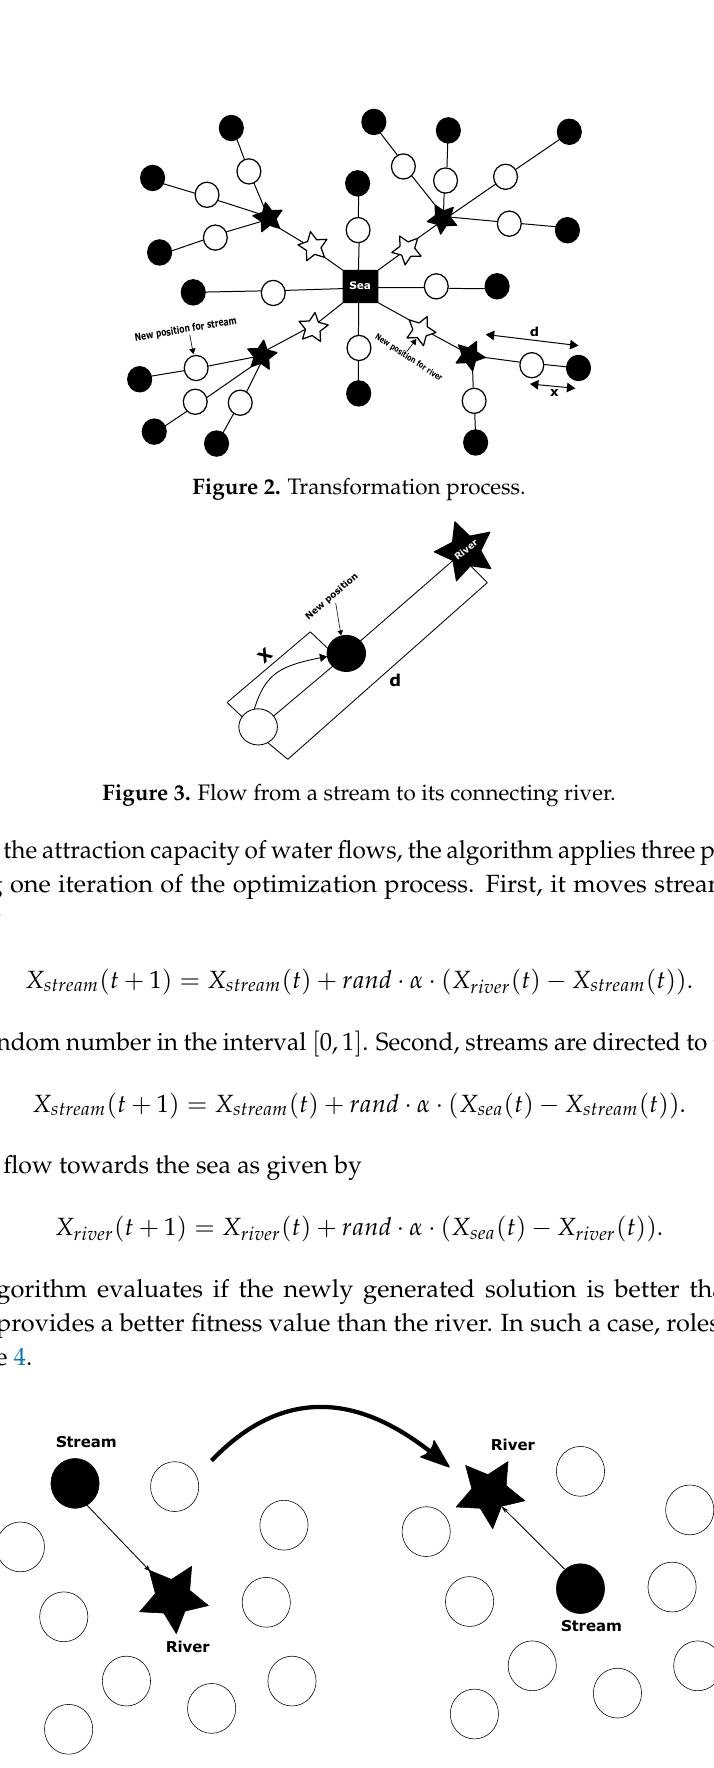
Figure 4. Exchange of roles between a stream and its